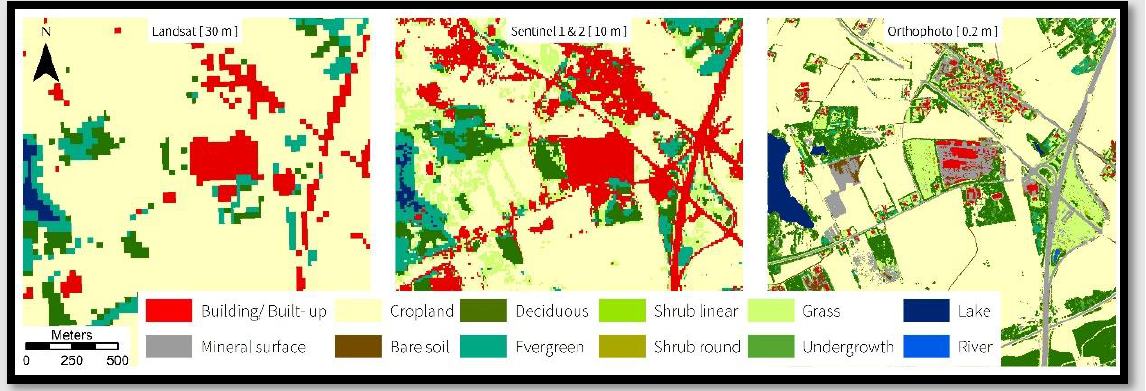
Figure 6. Scale-dependent aggregation of spatial knowledge consisting of land-cover and land-use data obtained by remote sensing techniques. The change in distribution of the different land cover and land use can be seen along the gradient of the spatial resolution. While Landsat and Sentinel 2 are optical remote sensing satellites, Sentinel 1 uses radar for imaging. The orthophotos were taken using airplanes.